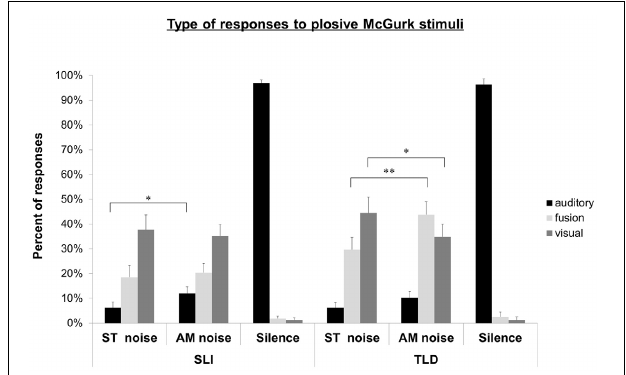
FIGURE 2 | Experiment 2. Auditory, fusion, and visual responses to McGurk plosive stimuli for SLI and TLD groups in ST noise, AM noise and quiet conditions. ∗ p < 0 . 05; ∗∗ p < 0 . 01.